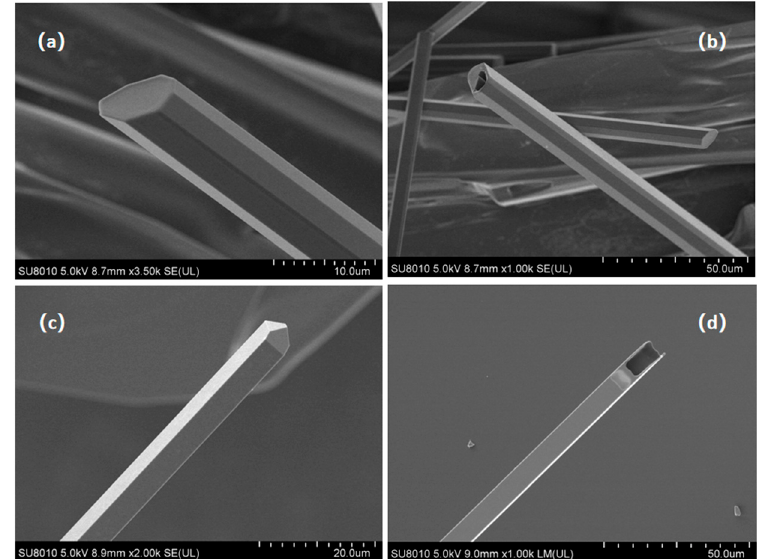
Figure 1. SEM images of the DKDP single-crystalline fibers obtained by rapid crystallization on glass substrate. ( a , b ) polyhedral solid-core / tubular single-crystalline fibers. ( c , d ) tetragonal solid-core / tubular single-crystalline fibers. Table 1. Basic crystallographic data comparison of the monoclinic DKDP bulk crystal, monoclinic DKDP, and KDP single-crystalline